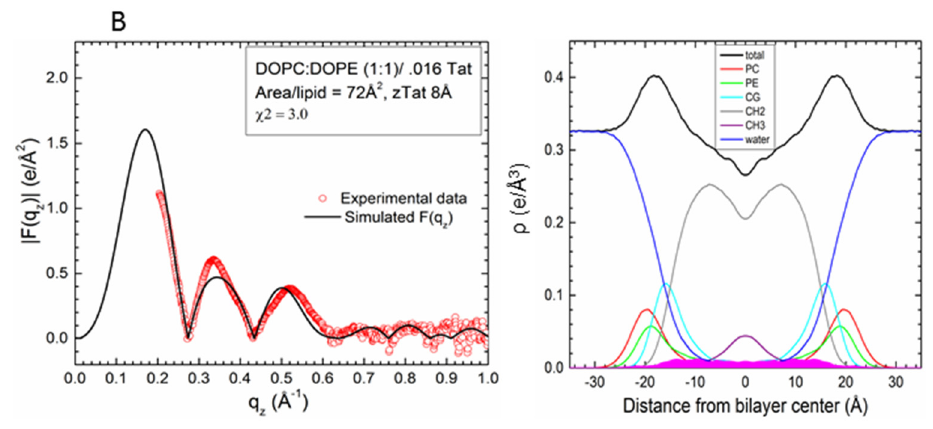
Figure 5. Detailed comparison of |F(q z )| ( left ) between DOPC:DOPE (1:1) with a Tat 47–57 mole fraction of 0.015/0.016 (simulation/experiment) at the values of z and A L that yielded the smallest χ 2 values: ( A ) z = 18 Å, A L = 68 Å 2 , χ 2 = 2.60 ± 0.02 and ( B ) z = 8 Å, A L = 72 Å 2 , χ 2 = 3.04 ± 0.20. Experimental data were scaled to the simulated |F(q z )|. Electron density profiles ( right ) of the same simulations with component groups indicated in the figure legend. Tat 47–57 electron density shown in solid magenta; other abbreviations as in Figure 4.